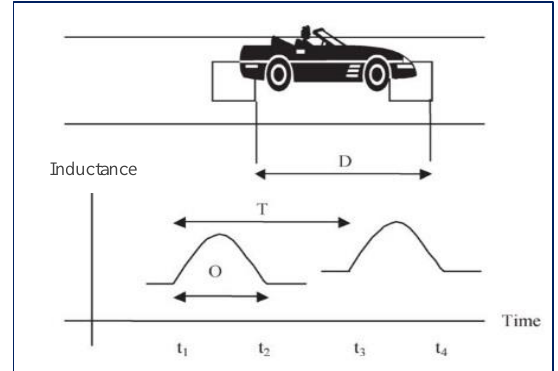
Figure 5. Loop Inductance Curves as vehicle passes over both the loops in a same